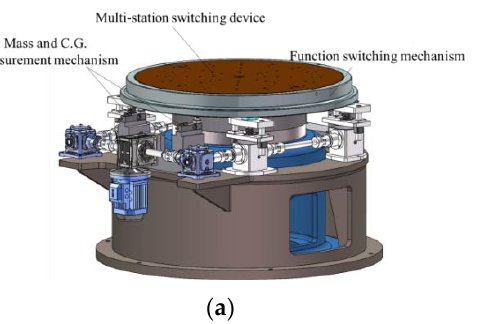
ment — vertical state.